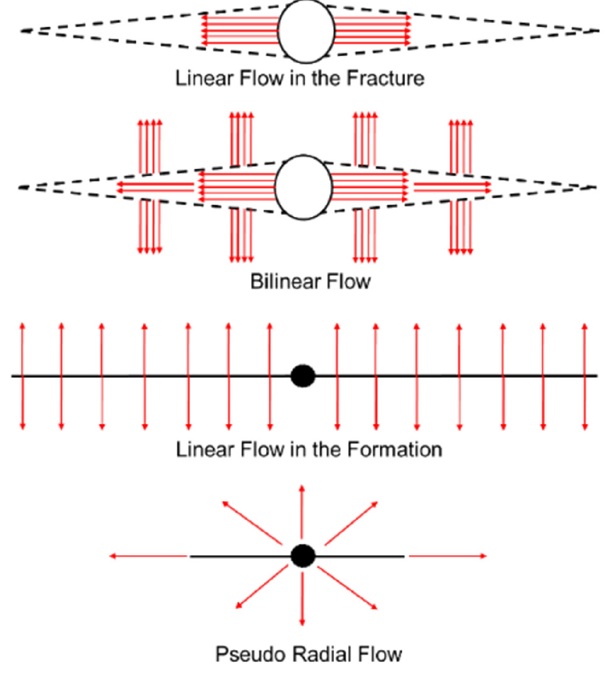
Figure 3. Typical flow regimes before and after closure behaviors. Investigating compelling field evidence using a downhole measurement that indicates what exactly occurs in the subsurface is paramount. Figure 4 illustrates the tiltmeter measurements of well #2B from the Gas Research Institute/Department of Energy M-site, which is defined as an indication of fracture displacement or fracture width [29].